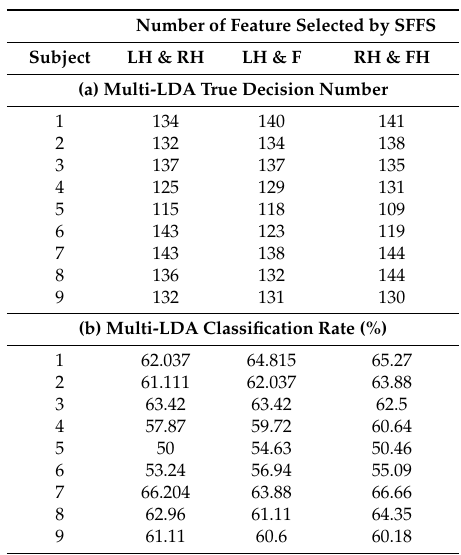
Table 7. Multi-LDA classification results true decision